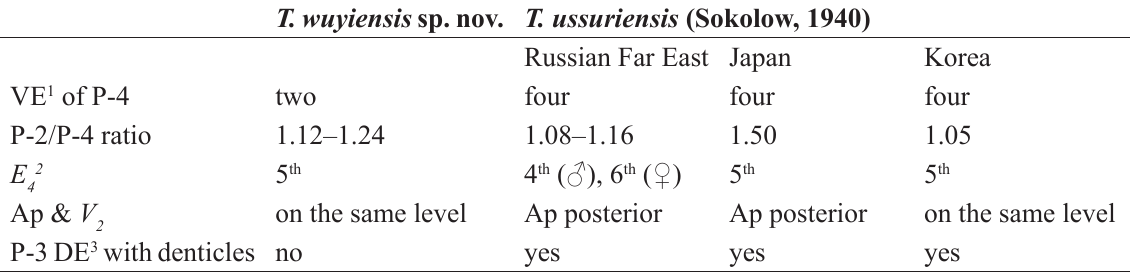
Table 1. Differences in diagnostic characters between Torrenticola wuyiensis sp. nov. and Torrenticola ussuriensis (Sokolow,